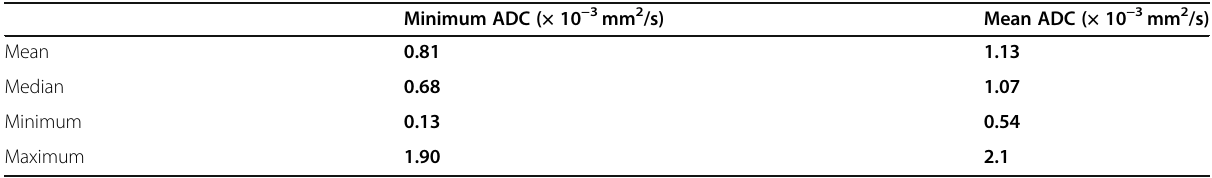
Table 1 Detailed analysis of ADC